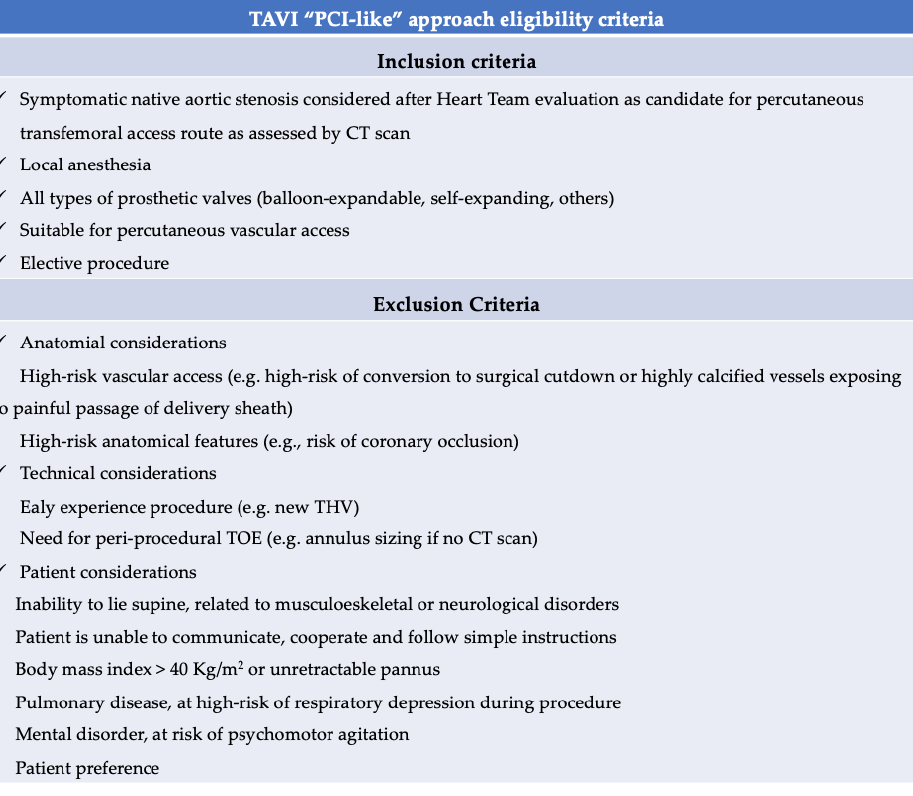
Figure 3. Eligibility criteria for the “PCI - like” approach. Adapted from Denimal T et al.